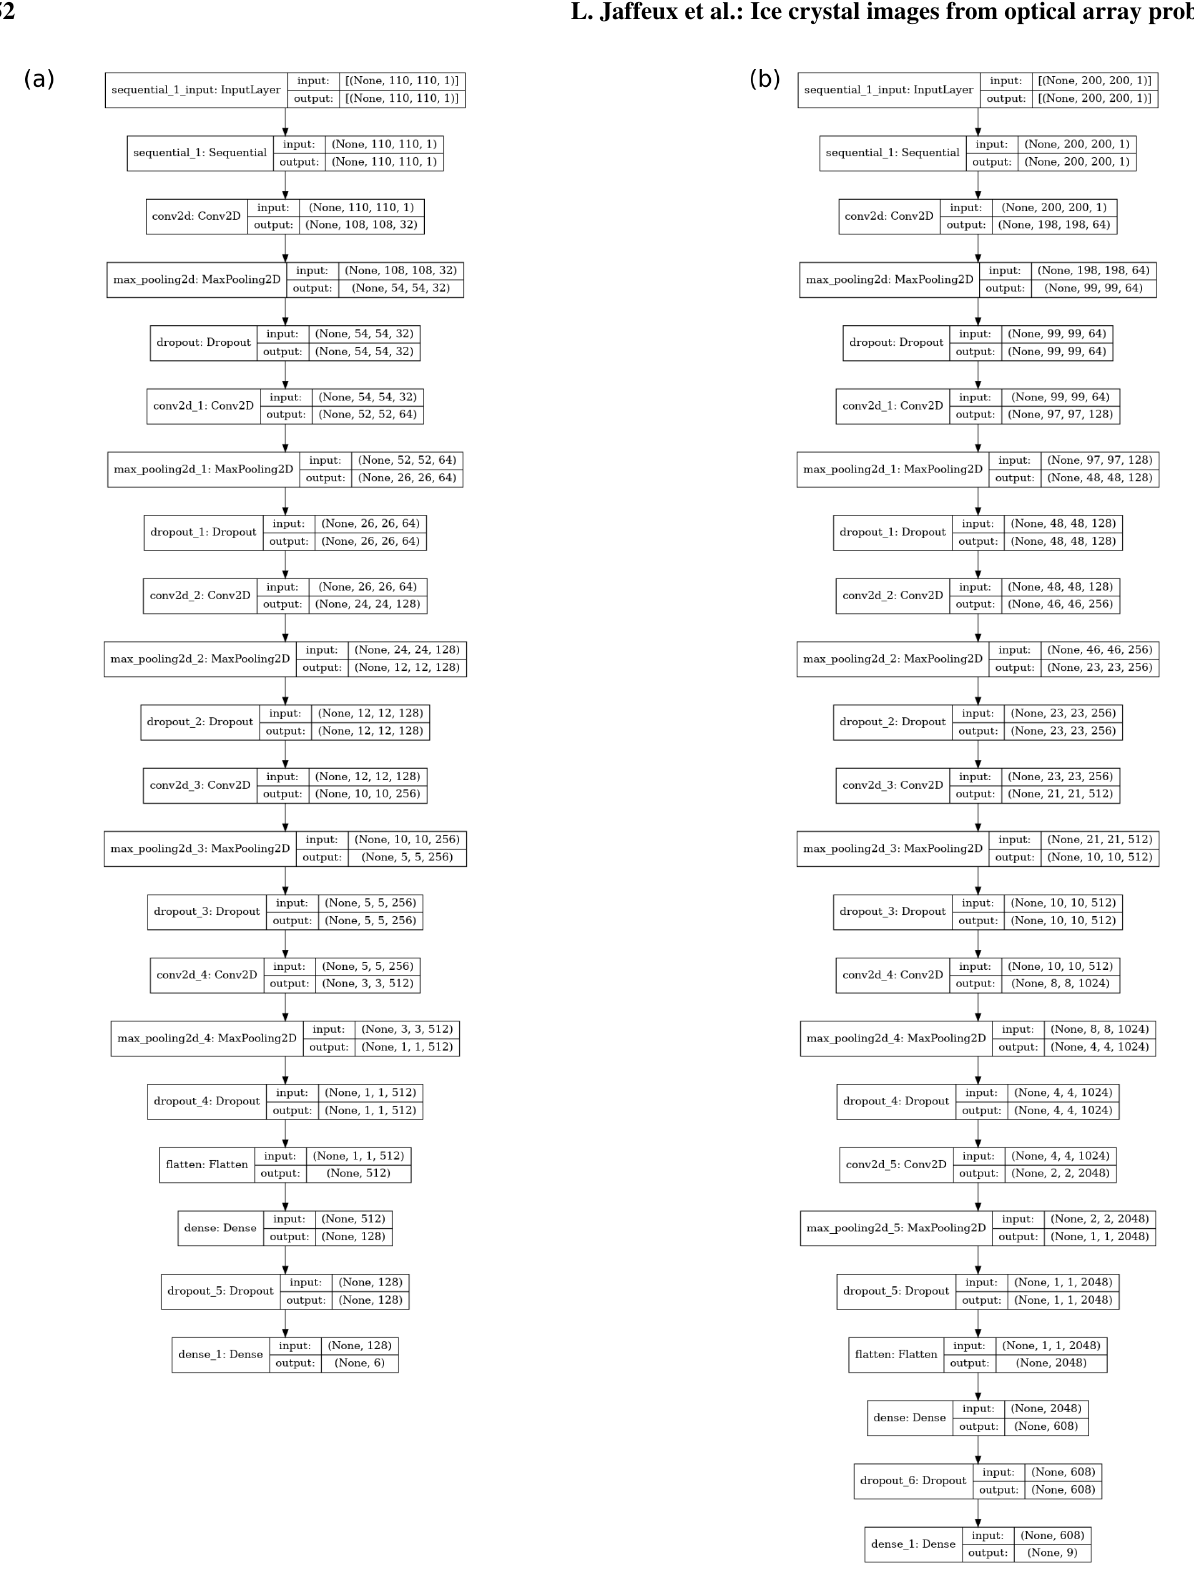
Figure A2. Model plot for each probe: PIP (a) and 2DS (b)